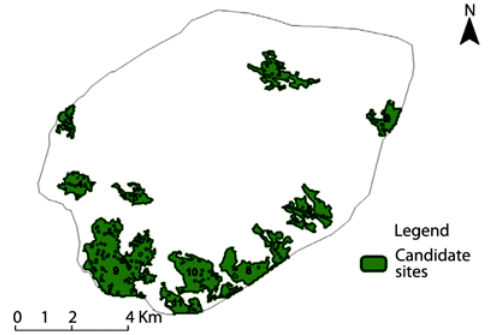
Fig. 6. Selected candidate